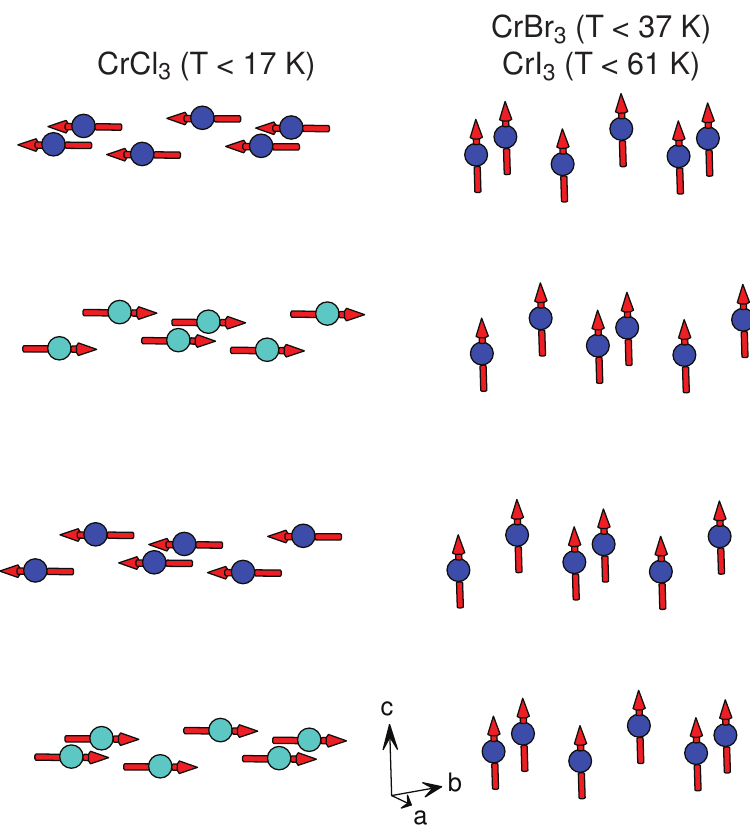
Figure 8. Magnetic structures of Cr X 3 . The hexagonal coordinate system of the low temperature rhombohedral structure is shown. The moments in CrCl 3 are drawn along the [110] and [110] directions here, but are only known to be in the ab plane. Moments are along the c axis in ferromagnetic CrBr 3 and CrI 3